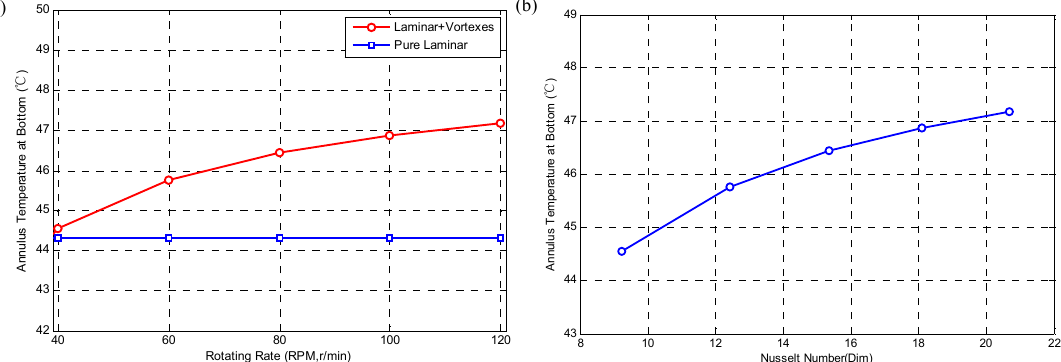
Figure 9. Variation of temperature at wellbore bottom with the increase in ( a ) rotating rate and ( b ) Nusselt number, Nu .